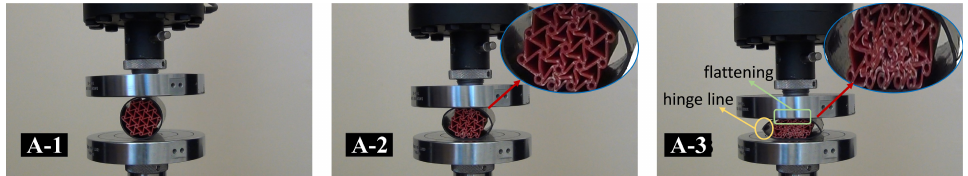
Figure 13. Undeformed ( A-1 ), 12.5 mm deflection applied ( A-2 ), and 25 mm deflection applied ( A-3 ) lattice-filled composite tubes.